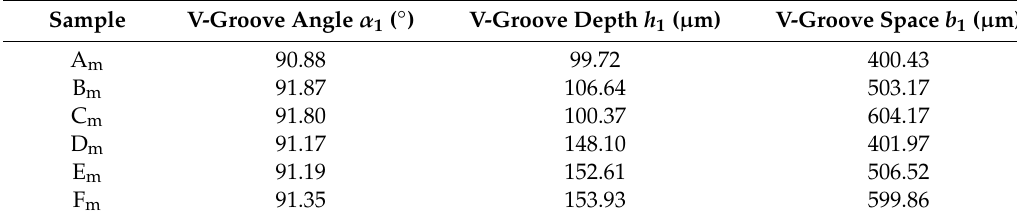
Table 4. The V-grooved structure parameters of micro-ground mold